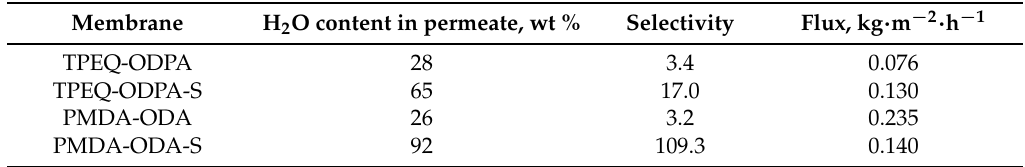
Table 1. Pervaporation of butanol–water mixture (10 wt % of water) using polyimide membranes and